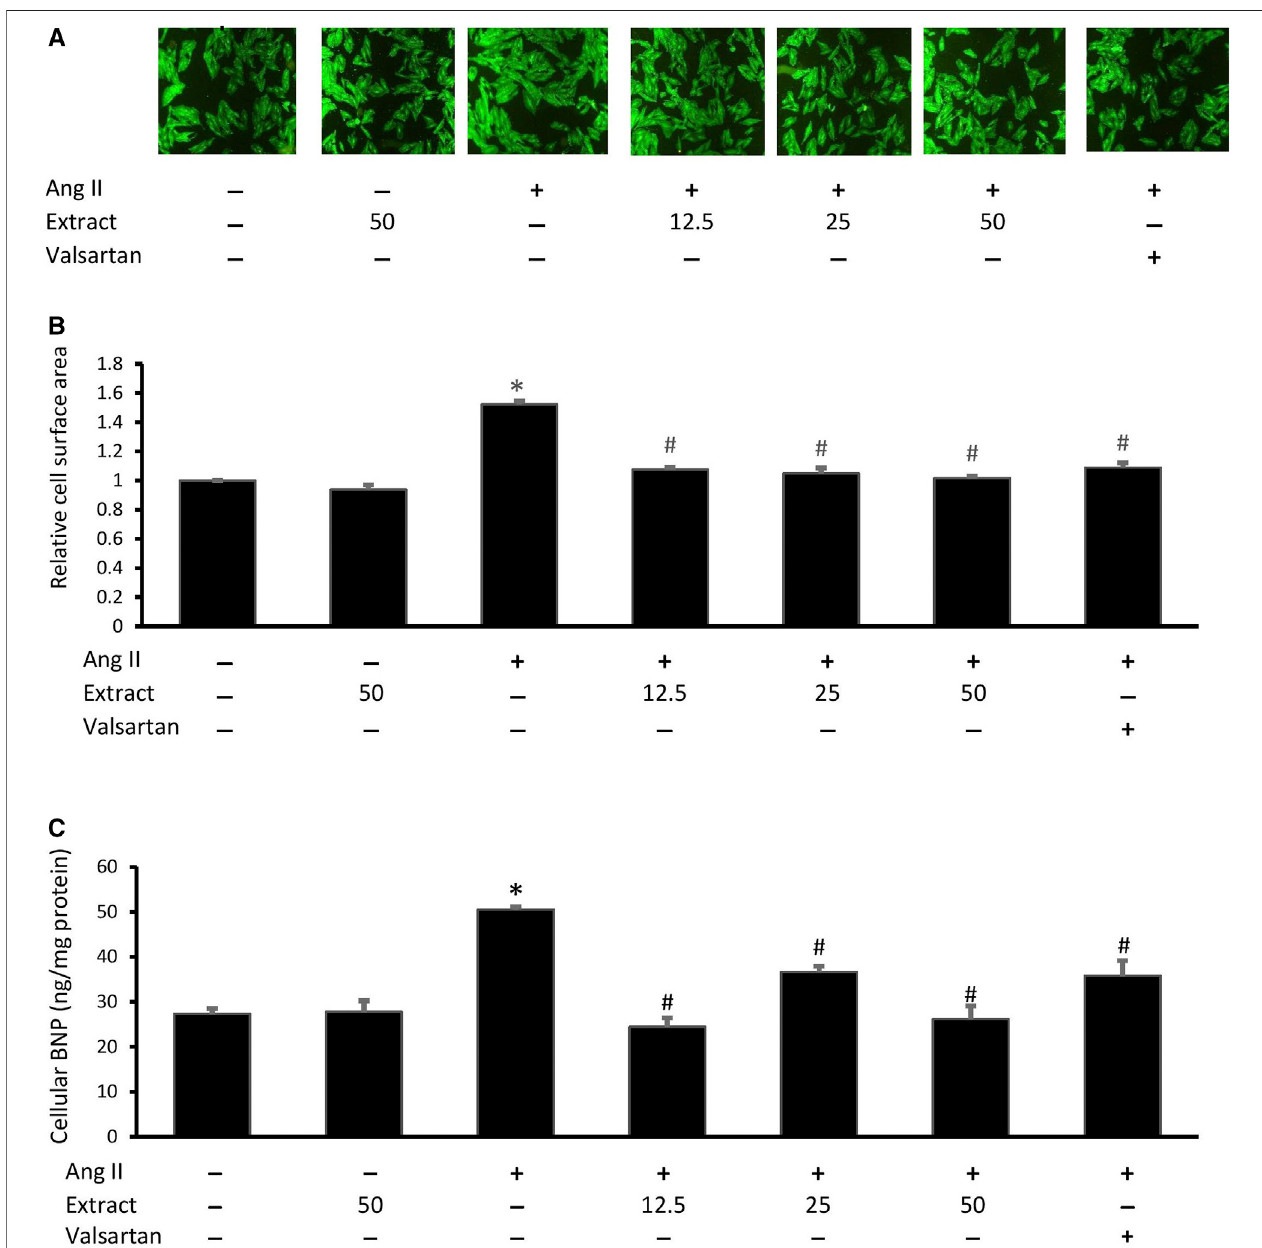
FIGURE 7 | Effect of Parkia speciosa empty pod extract ( μ g/ml) or valsartan (20 μ M, positive control) co-incubation on Ang II (600 nM)-induced H9c2 cell hypertrophy seen in (A) representative immuno fl uorescent-stained cells (magni fi cation × 100), (B) cell surface area, and (C) B-type natriuretic peptide (BNP) after 24 h * p < 0.05 vs. control (no treatment) group. # p < 0.05 vs. Ang II group. Results are presented as the mean ± SEM ( n (cid:2) 3).